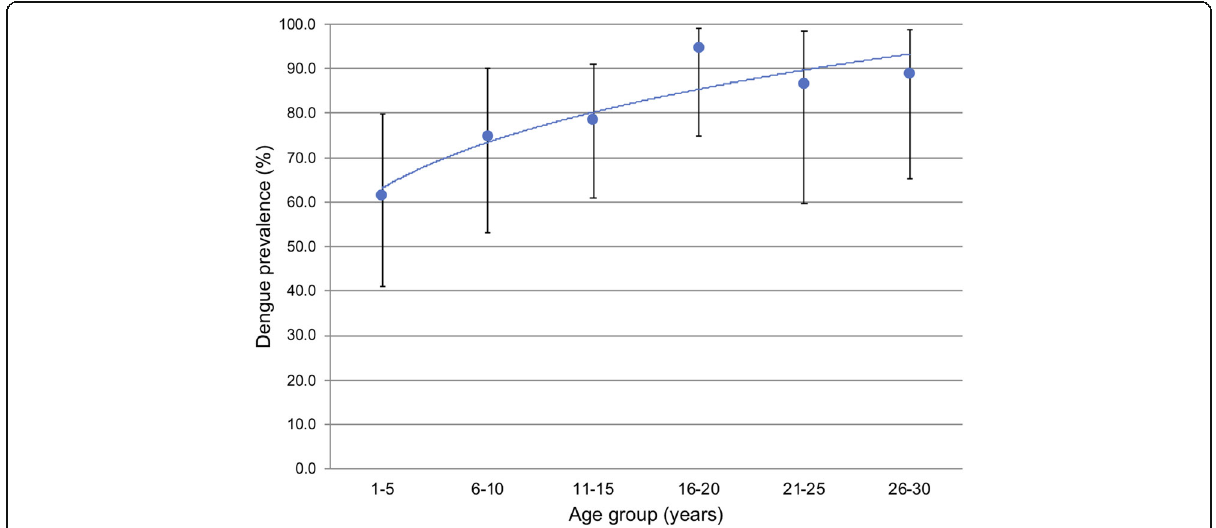
Fig. 3 The prevalence of the DENV in different age groups in the household survey